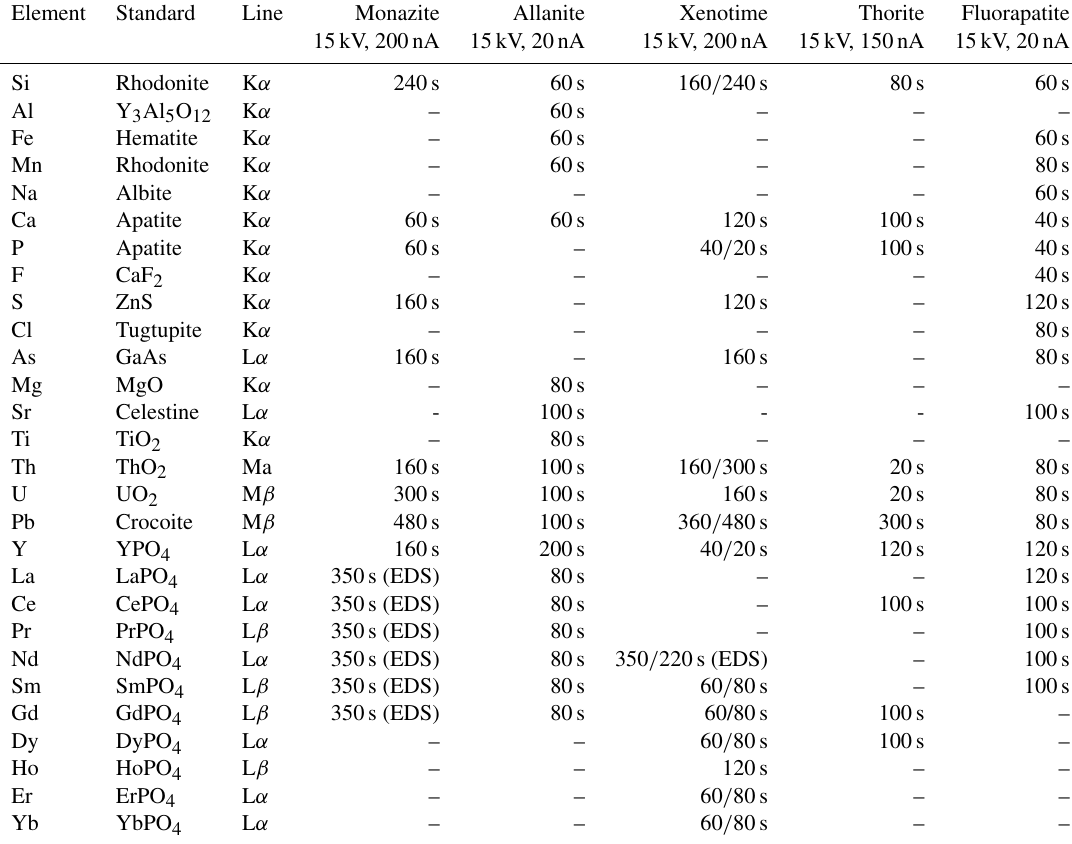
Table A1. Electron microprobe measurement conditions used in this